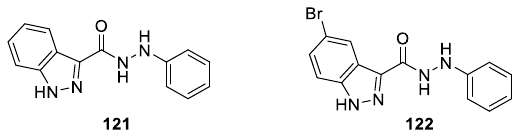
Figure 28. Chemical structures of 3-substituted 1 H -indazoles 121 and 122 .